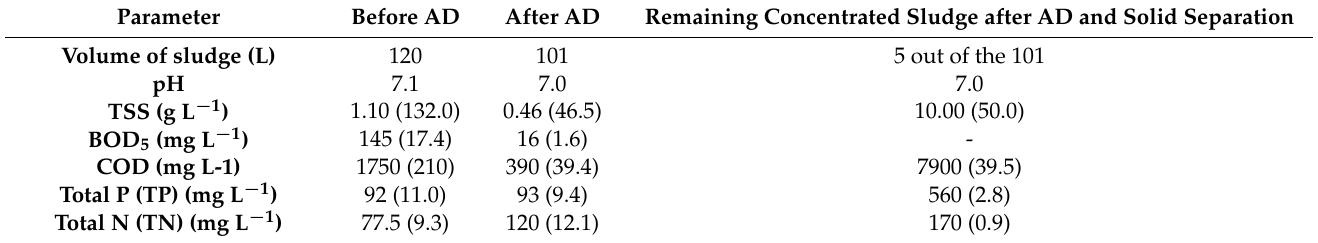
Table 1. Characteristics of aquacultural sludge before and after aerobic digestion. Mean values are given. Parameter Before AD After AD Remaining Concentrated Sludge after AD and Solid Separation Volume of sludge (L) 120 101 5 out of the